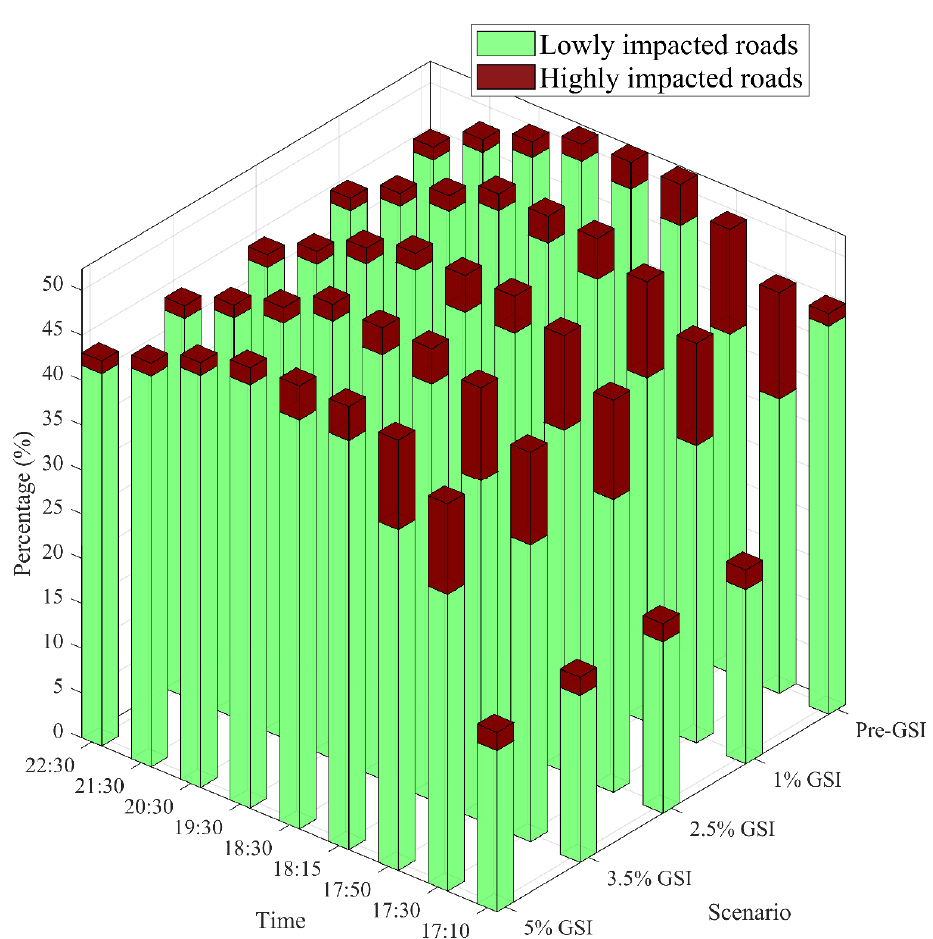
Figure 9. Percentage of roadways with high (>25% reduction in maximum vehicle speed) and low ( ≤ 25% reduction in maximum vehicle speed) impacts caused by flooding.